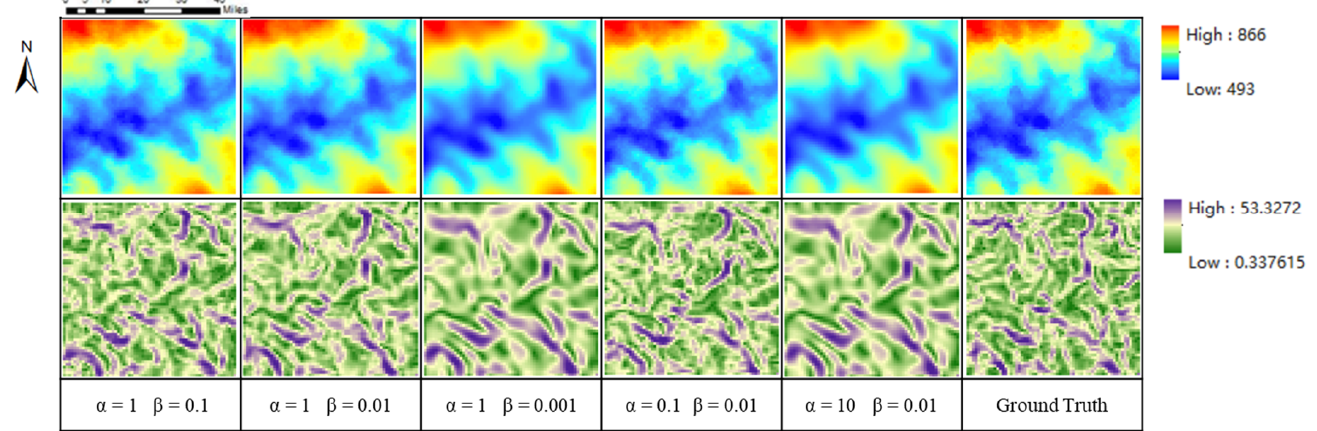
Figure 16. DEM and slope of our method (GISR) with different parameter